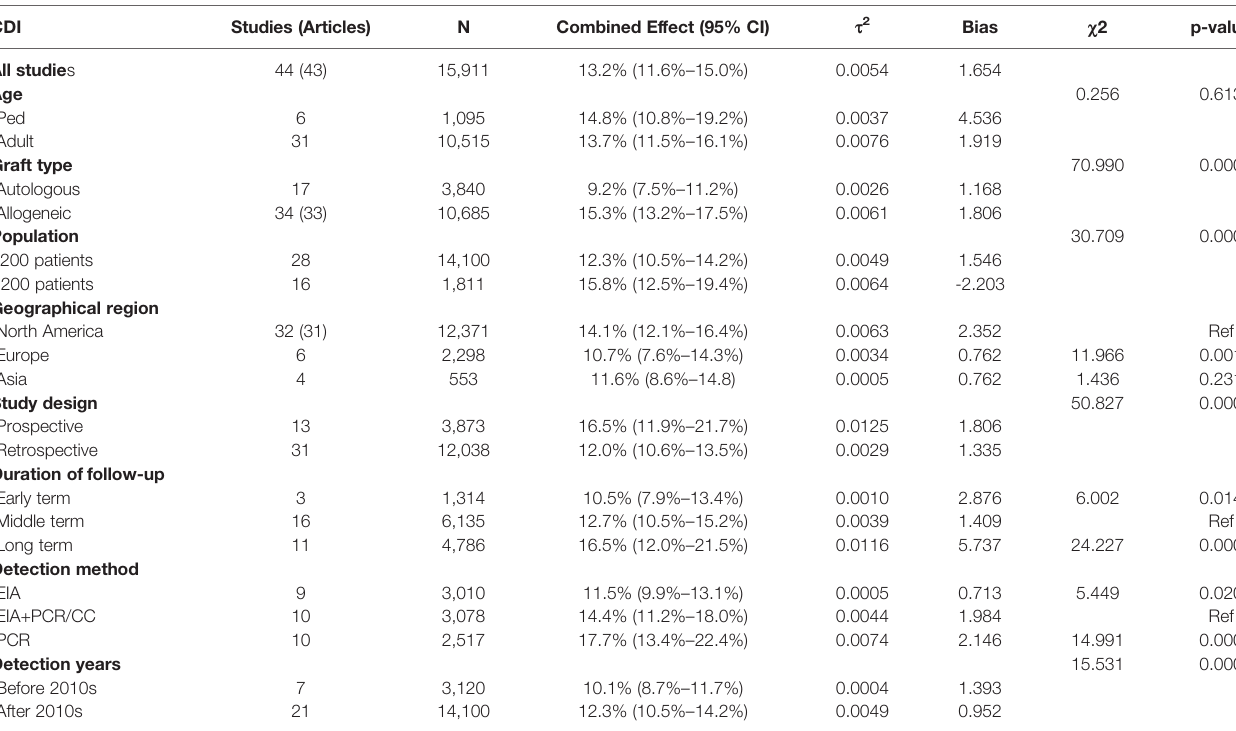
TABLE 2 | Summary